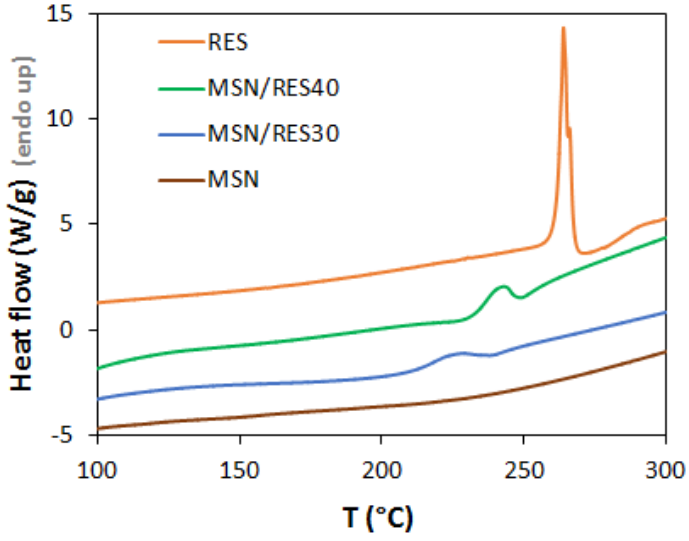
Figure 3. Differential scanning calorimetry (DSC) profile of pristine MSN, RES, and loaded MSN/RES30 and MSN/RES40 samples.